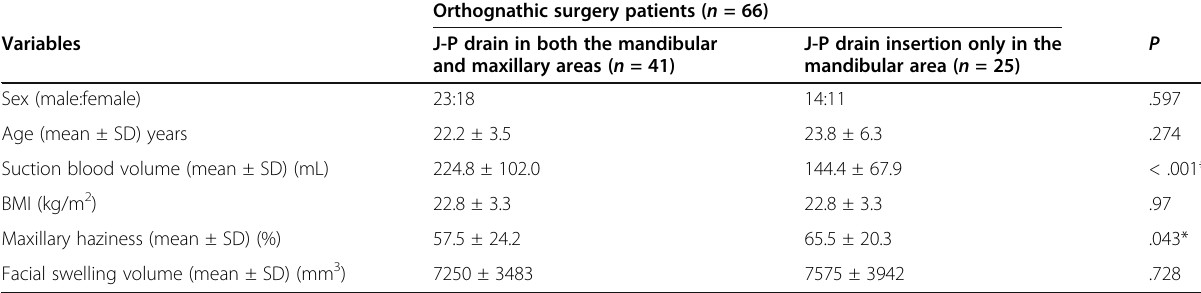
Table 1 Results of maxillary sinus haziness and facial swelling following suction drainage in the maxilla according to the drain insertion after orthognathic surgery